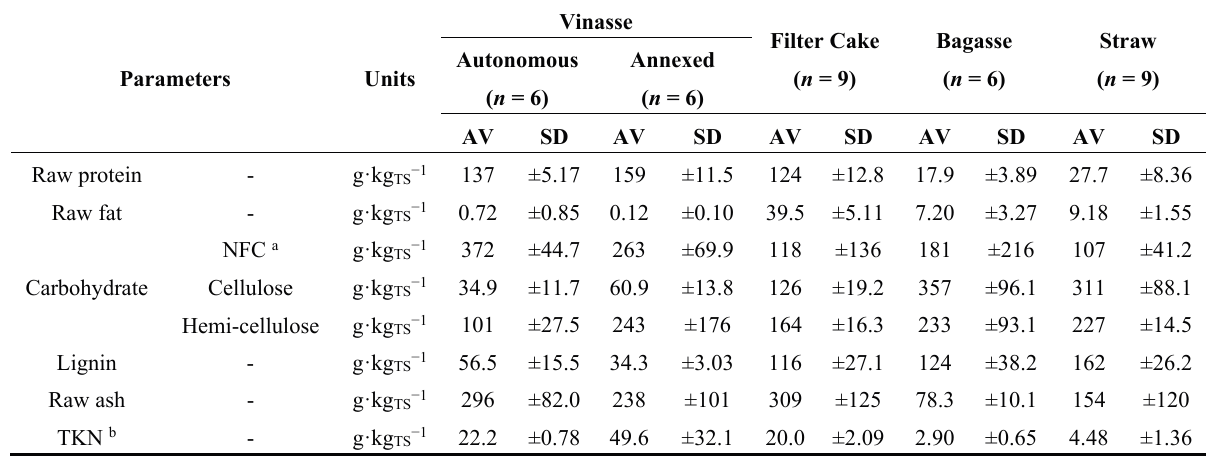
Table 3. Nutritional values of the sugarcane